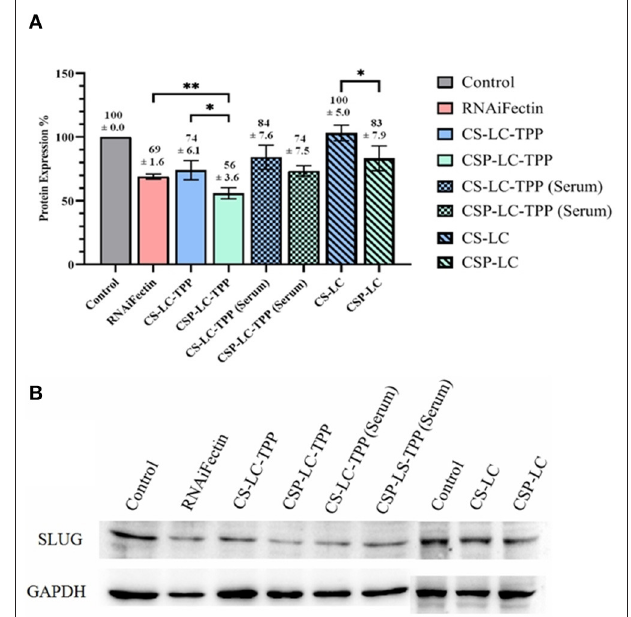
FIGURE 3 | SLUG Protein silencing in response to anti-SLUG siRNA-loaded NPs and RNAiFectin. (A) Histogram showing SLUG protein expression in response to different NPs formulas. The numbers above each bar represent the average SLUG protein expression percentage ( ± SD) of triplicate trials. ns: no significant difference, *significant difference at P < 0.05, **significant difference at P < 0.01. (B) Image showing the gel electrophoresis membrane for Western blotting. GAPDH (glyceraldehyde-3-phosphate dehydrogenase) protein expression was used as loading control. Un-transfected cells were used as controls. Supplementary Figures 4A,B show the complete Western blot